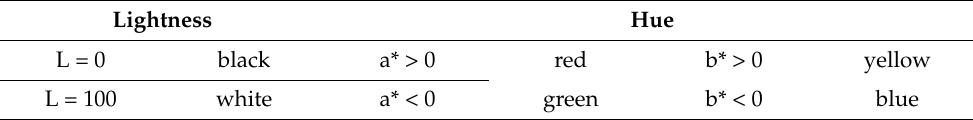
Table 1. CIELAB parameters meaning. Lightness Hue